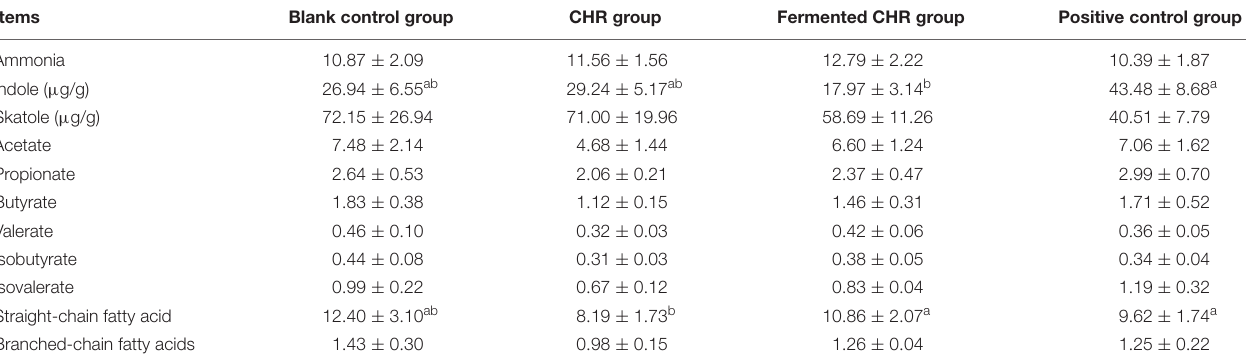
TABLE 6 | Effects of dietary supplementation with Chinese herbal residues (CHR) or fermented CHR on bacterial metabolite concentrations in the colonic content in weaned piglets ( n = 5;